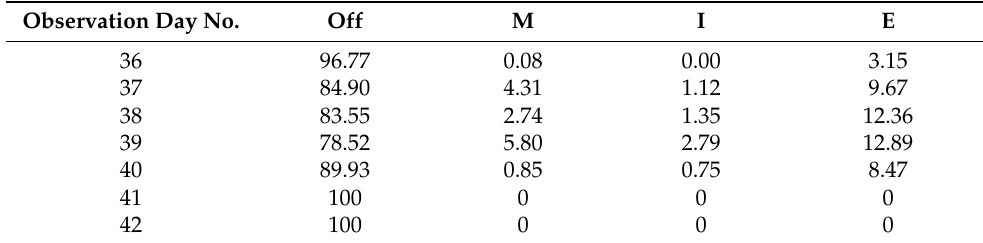
Table 6. Extract from the results of the machine structure. Observation Day